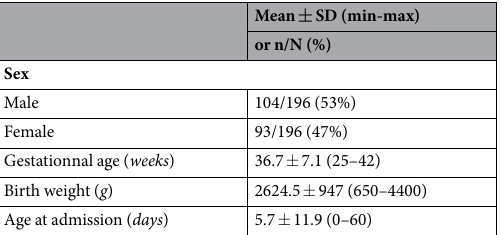
Table 2. Demographic characteristics of the studied population of 196 neonates for whom metabolic testings were